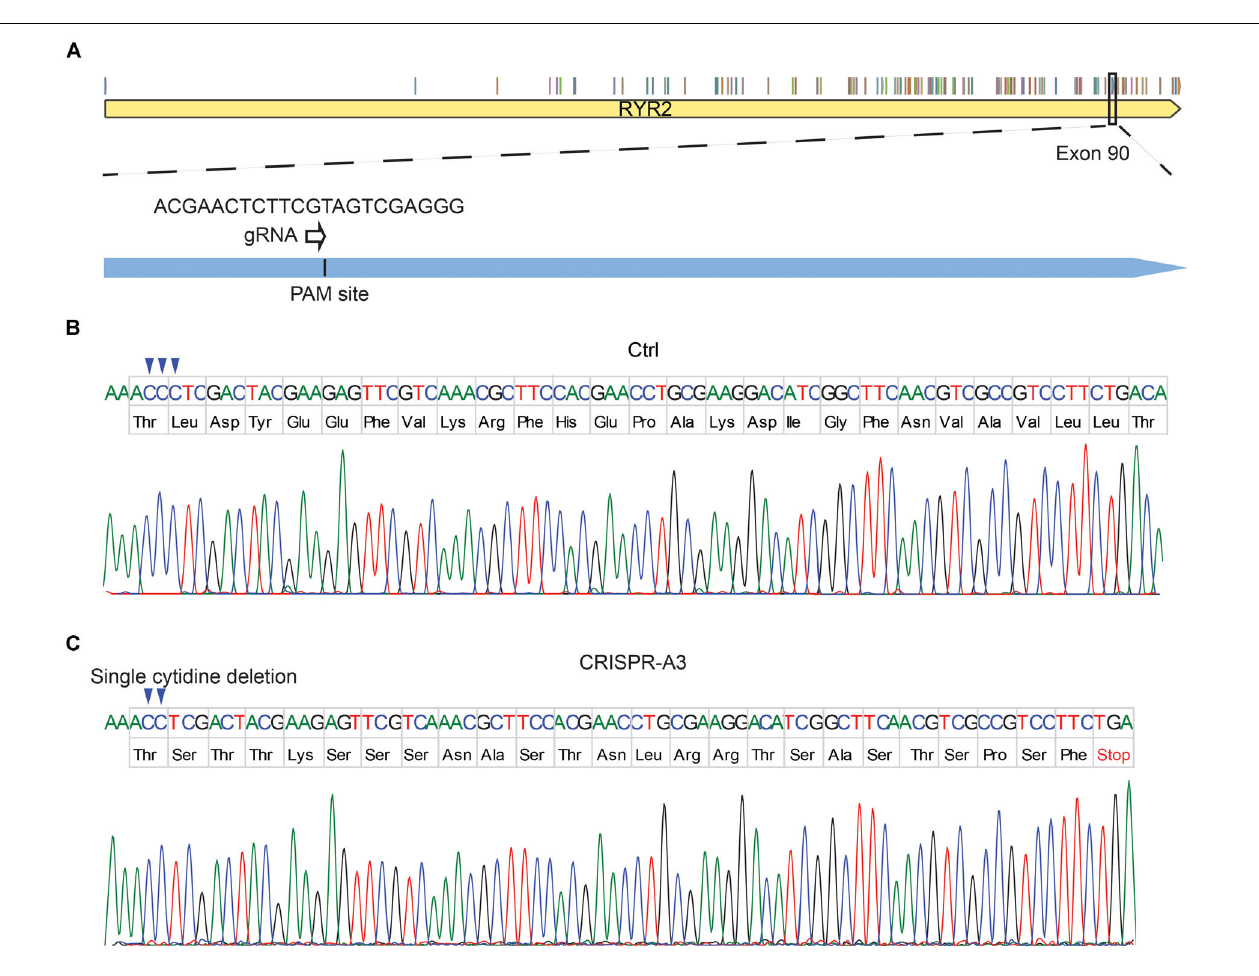
FIGURE 1 | Generation of human homozygous RYR2 knockout iPSCs (RYR2 − / − -iPSCs). (A) Illustration of the RYR2 locus and gRNA1 designed for CRISPR/Cas9-mediated gene editing in exon 90 of RYR2 . (B,C) DNA sequencing of Ctrl- (B) and CRISPR/Cas9-edited A3 RYR2 − / − -iPSC lines (C) . The A3 RYR2 − / − -iPSC line displayed a single homozygous cytidine deletion in the RYR2 gene, which resulted in a premature termination codon